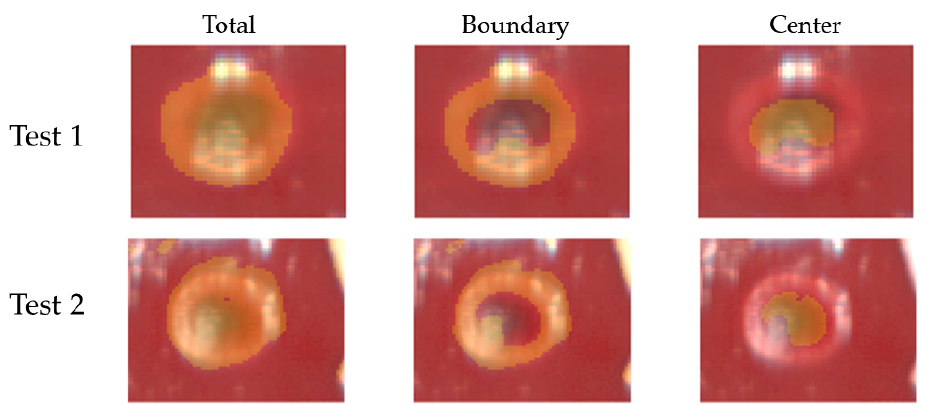
Figure 11. Results of segmentation for Test 1 and Test 2. Masks extracted using the thresholding technique were used to segment total damaged, boundary, and center zones in the RGB images acquired by the hyperspectral camera at the end of the ablation procedure and clearly showing the thermal outcome.